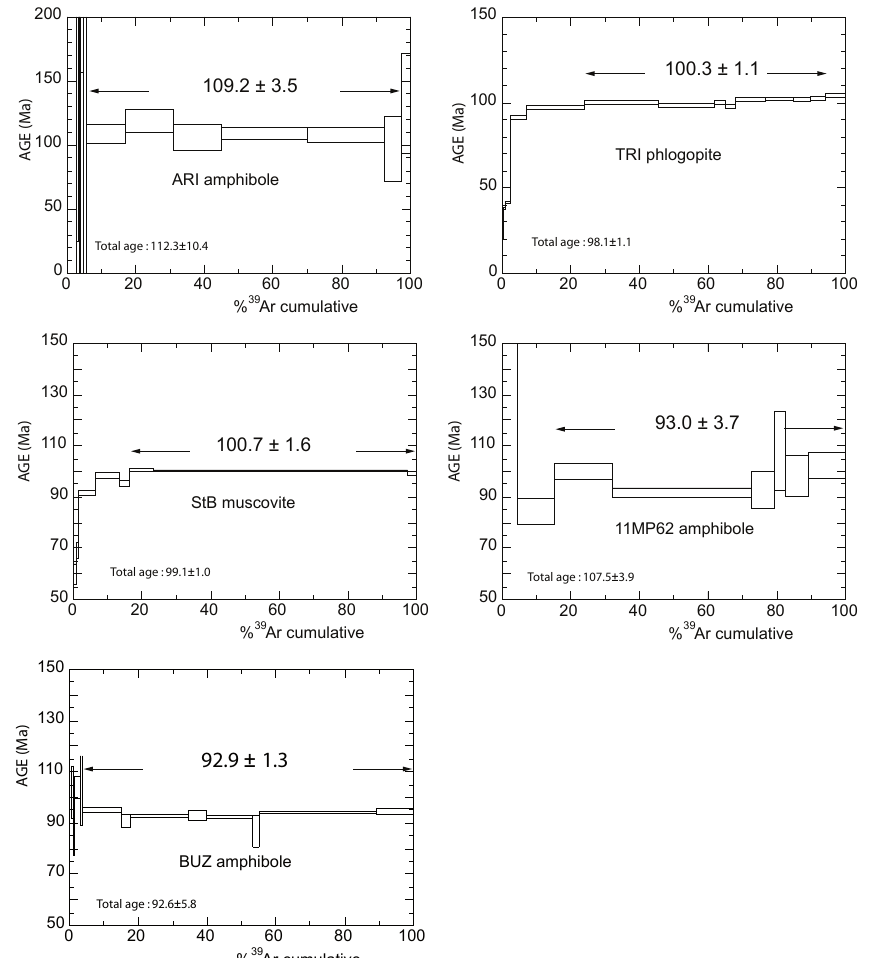
Figure 11. 40 Ar– 39 Ar step-heating data for the samples ARI, TRI, StB, 11MP62 and BUZ.